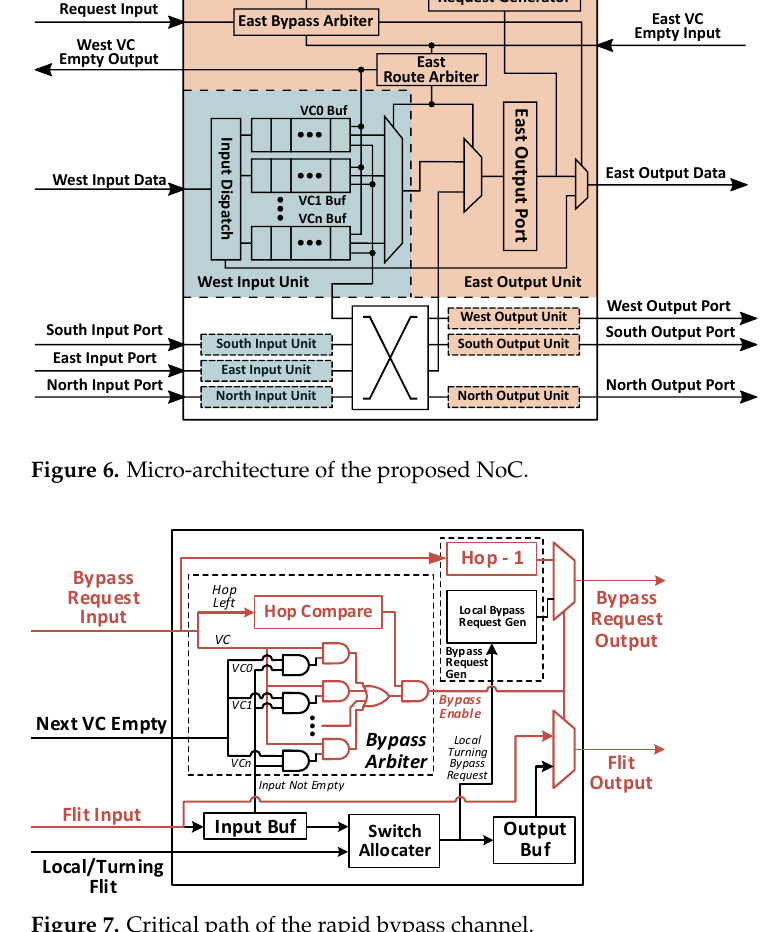
Figure 7. Critical path of the rapid bypass